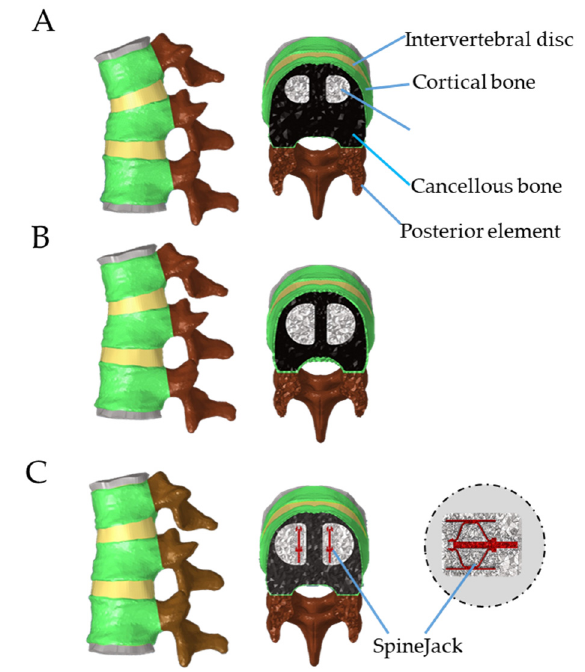
Figure 3. T11-L1 finite element model representing three types of cement augmentation technique. ( A ): Vertebroplasty (VP). ( B ): Balloon kyphoplasty (BKP). ( C ): Vertebrae stent (VS).